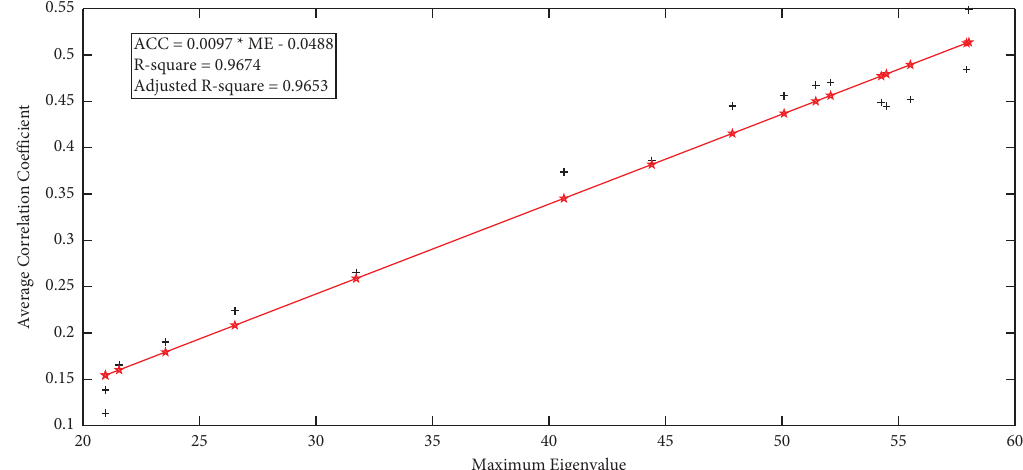
Figure 4: Regression diagram of the maximum eigenvalue and average correlation coefcient.